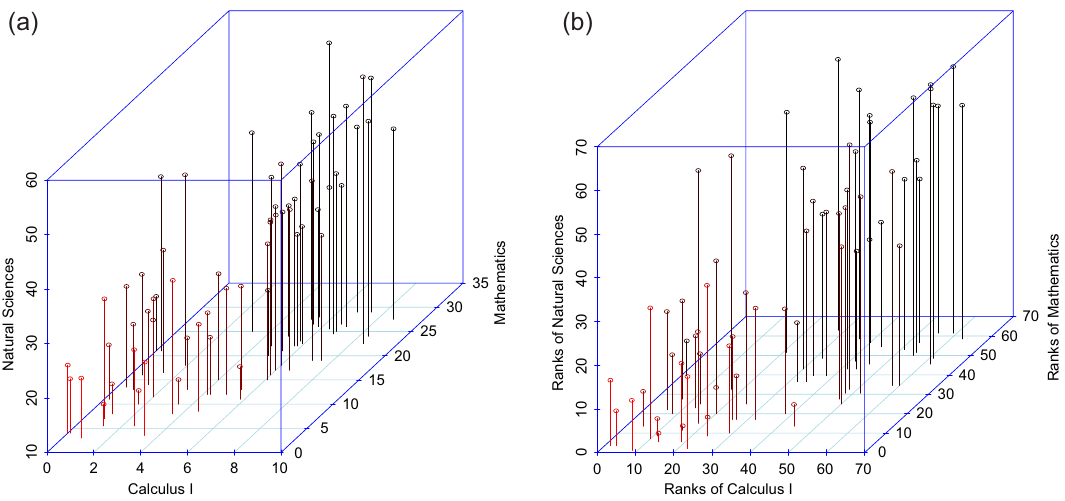
Figure 5. Data of 2014. (a) Scatterplot between Calculus I , Mathematics and Natural Sciences , from red to black color in increasing order in relation to the “ Mathematics ” axis. (b) Scatterplot between ranks of Calculus I , ranks of Mathematics and ranks of Natural Sciences , from red to black color in increasing order in relation to the “ Ranks of Mathematics ”